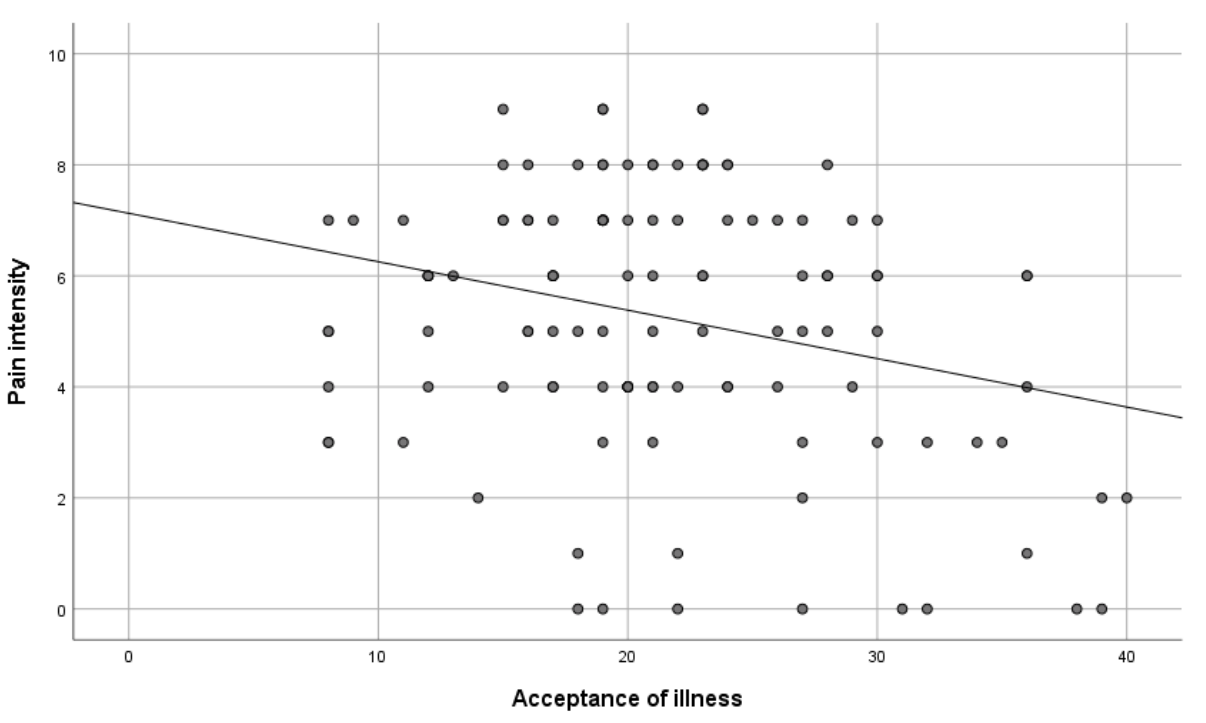
Figure 2. Pain intensity versus acceptance of illness.